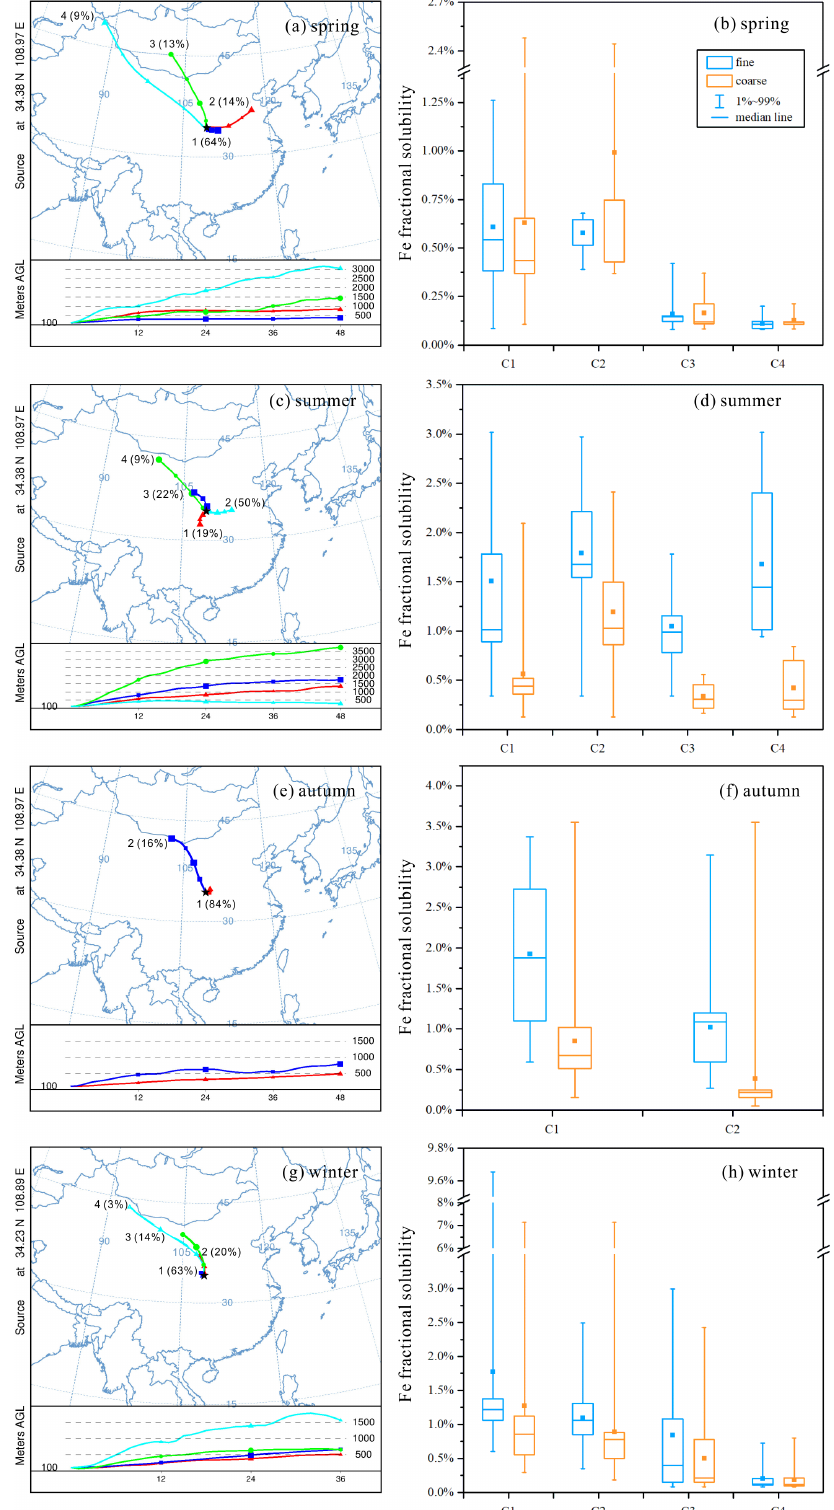
Figure 6. The mean back-trajectory clusters obtained by HYSPLIT for (a) spring, (c) summer, (e) fall, and (g) winter; Fe solubility in fine and coarse particles for different air mass clusters in (b) spring, (d) summer, (f) fall, and (h) winter. C1–C4 represent different air mass